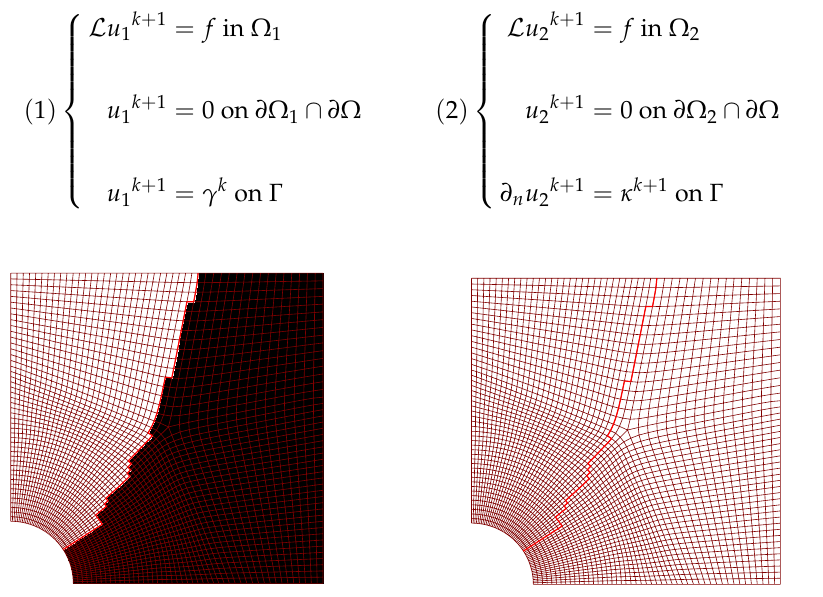
Figure 7. Dirichlet-Neumann (DN, left ) and the Neumann-Neumann ( right )